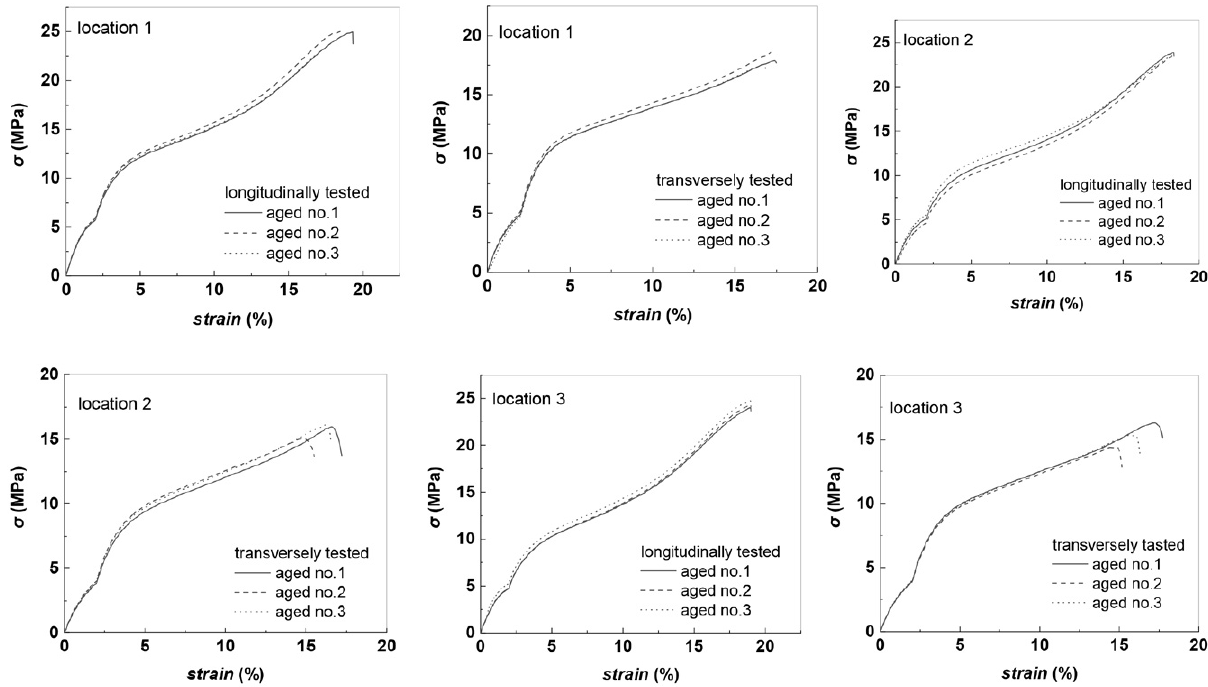
Figure 3. Tensile strength and elongation at break (load/strain curves) for aged, plasticized PVC membrane samples tested longitudinal (left) and transverse (right) directions at conditions: T = 393.15 ± 2 K, RH (relative humidity) = 50 ± 5